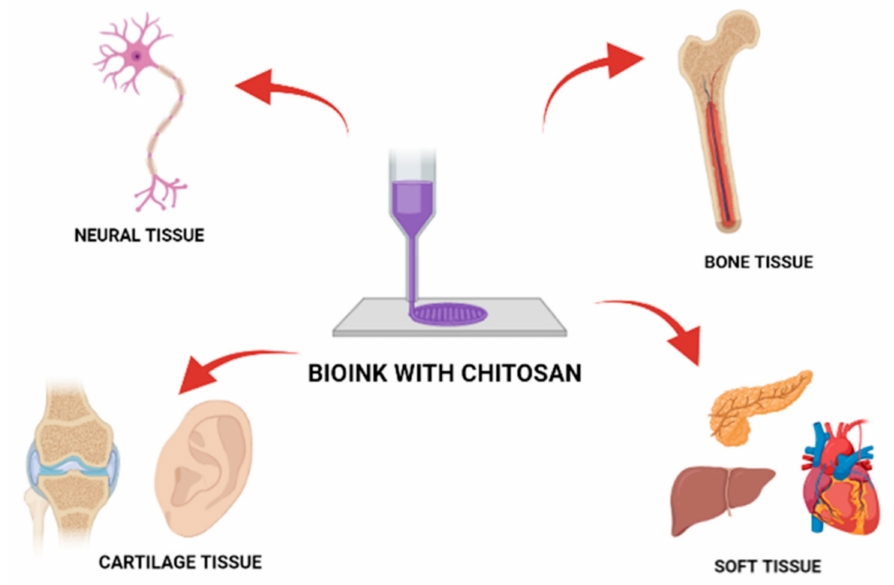
Figure 5. Application of chitosan bio-ink as an material for regenerative